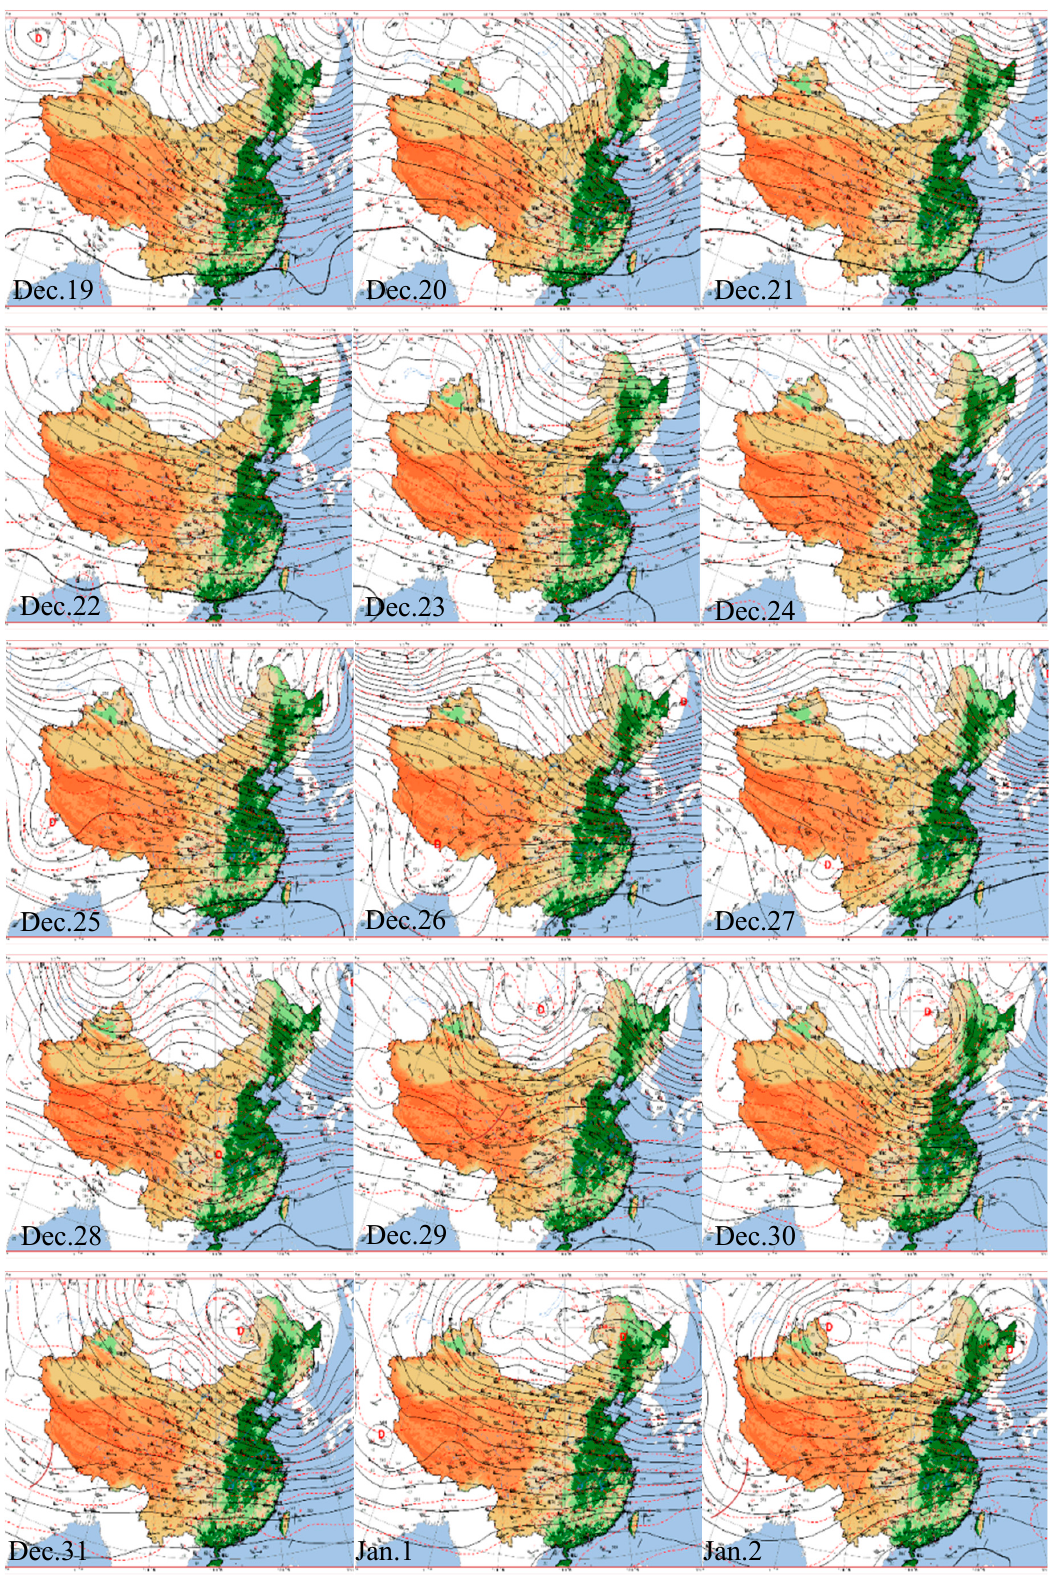
Figure 6. The 500 hPa synoptic charts at 08:00 CST from 19 December 2017 to 2 January 2018. The black solid lines represent the contour lines of potential height, the red dashed lines represent isotherms, and the red capital letter “D” locates the center of the low-pressure system.